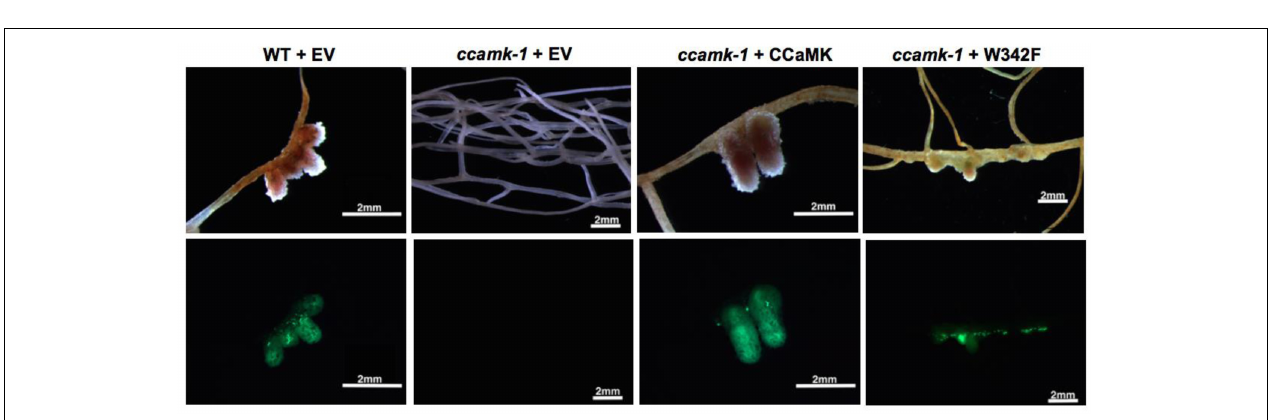
FIGURE 3 | The W342F mutant plants are able to form altered nodules. The roots of ccamk-1 mutant were transformed with the W342F mutant of CCaMK, roots of WT and ccamk-1 transformed with empty vector were used as positive and negative controls. (A) The number of nodules per plant for each construct was quantitated 28-days after inoculation with Sinorhizobium meliloti 2011-Green fluorescent protein (GFP). (B) Phenotypic difference of nodule development on ccamk-1 roots complemented with W342F and CCaMK. W342F mutation resulted in significant increase ( p -value = 0.00069) in the number of small nodules.